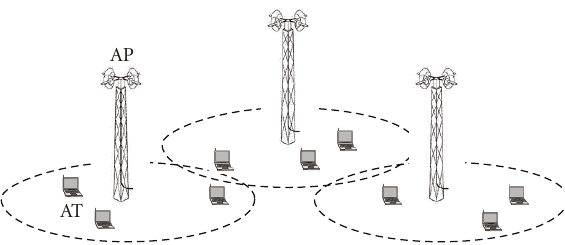
Figure 1: Illustration of multi-cell OFDMA